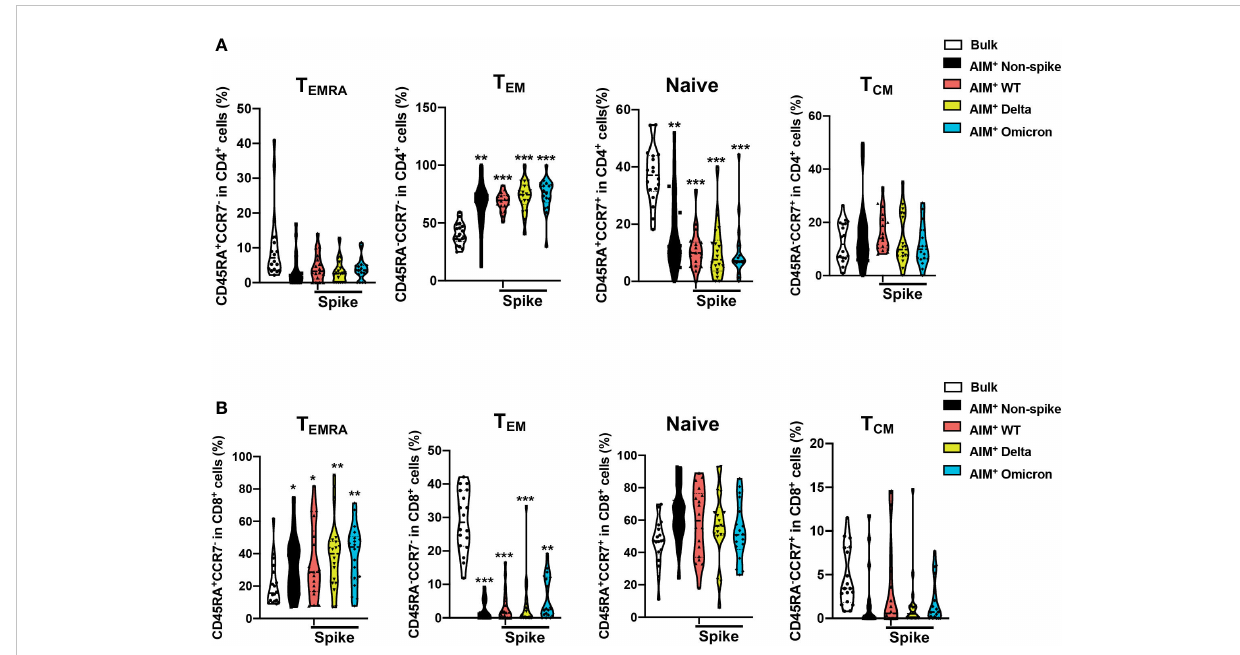
FIGURE 4 Distribution of memory T cell subsets among SARS-CoV-2 – speci fi c CD4 + and CD8 + T cells after a third dose of CoronaVac. The percentages of naive (CD45RA + CCR7 + ), central memory (T CM , CD45RA - CCR7 + ), effector memory (T EM , CD45RA - CCR7 - ), and terminally differentiated effector memory (T EMRA, CD45RA + CCR7 - ) in the bulk and SARS-CoV-2 AIM + populations for CD4 + (A) and CD8 + (B) T cells were determined by fl ow cytometry. The percentages of T memory subsets in the AIM + populations were compared with those of bulk CD4 + and CD8 + cells. Comparisons were performed via RM one-way ANOVA with Holm-S ̌ ı ́ da ́ k ’ s multiple comparisons test for parametric data or Friedman test with Dunn ’ s multiple comparisons test for nonparametric data. n = 18. * p < 0.05, ** p < 0.01, *** p <